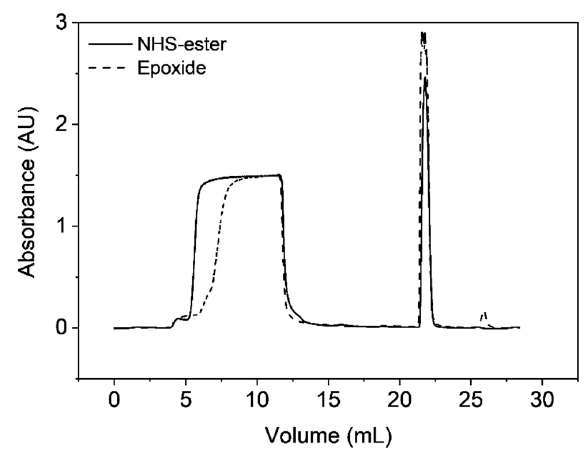
Figure 11. Breakthrough curves of produced protein A resins using microclusters with either NHS–ester or epoxide groups on their surface.